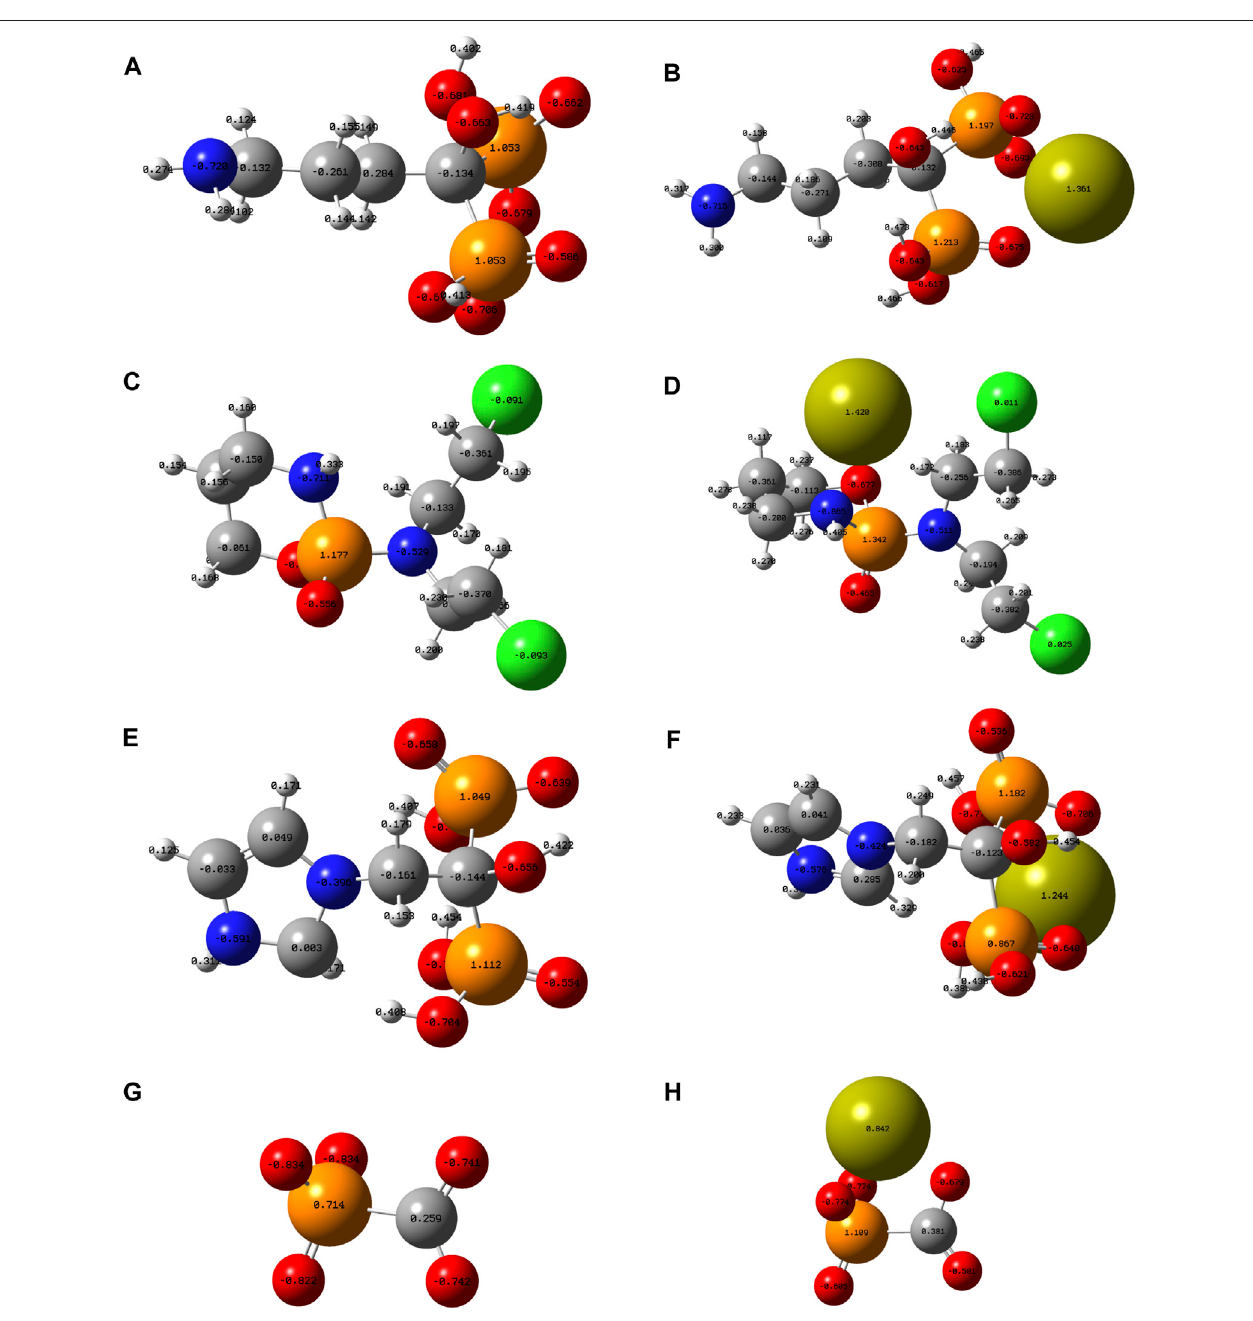
FIGURE 1 | Optimized atomic structure showing the electrostatic density of (A) Adn − , (B) Adn − + Ca 2+ , (C) Cpp, (D) Cpp + Ca 2+ , (E) Zda - , (F) Zda − + Ca 2+ , (G) Fss 3- , and (H) Fss 3- + Ca 2+ . Note: grey ball, carbon atom; white ball, hydrogen atom; blue ball, nitrogen atom; orange ball, phosphorus atom; lime-green ball, calcium atom; red ball, oxygen atom; and green ball, chlorine atom.